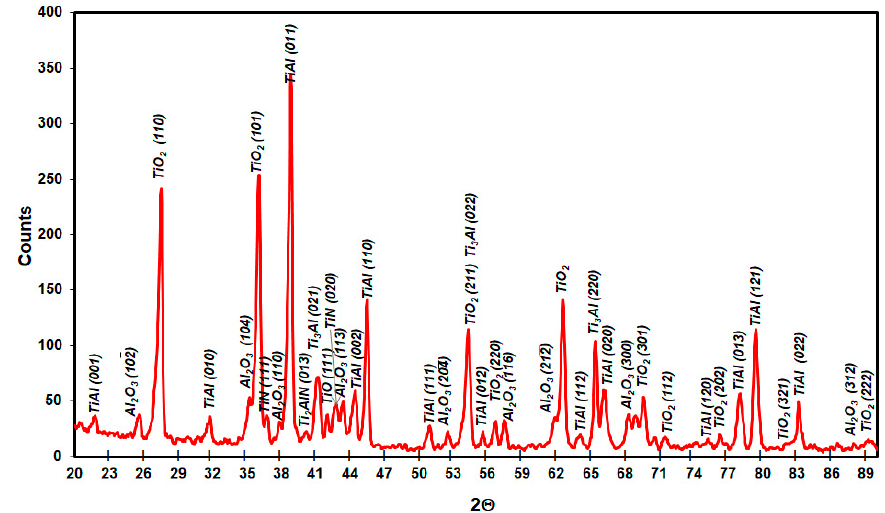
Figure 22. XRD pattern showing the predominant phases formed during oxidation of Ti–46Al–7Nb– 0.7Cr–0.1Si–0.2Ni alloy at 900 °C.